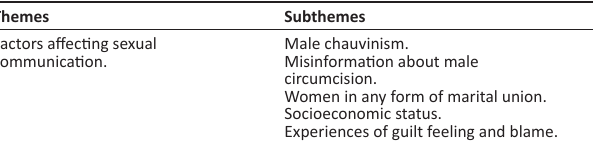
TABLE 1: Research